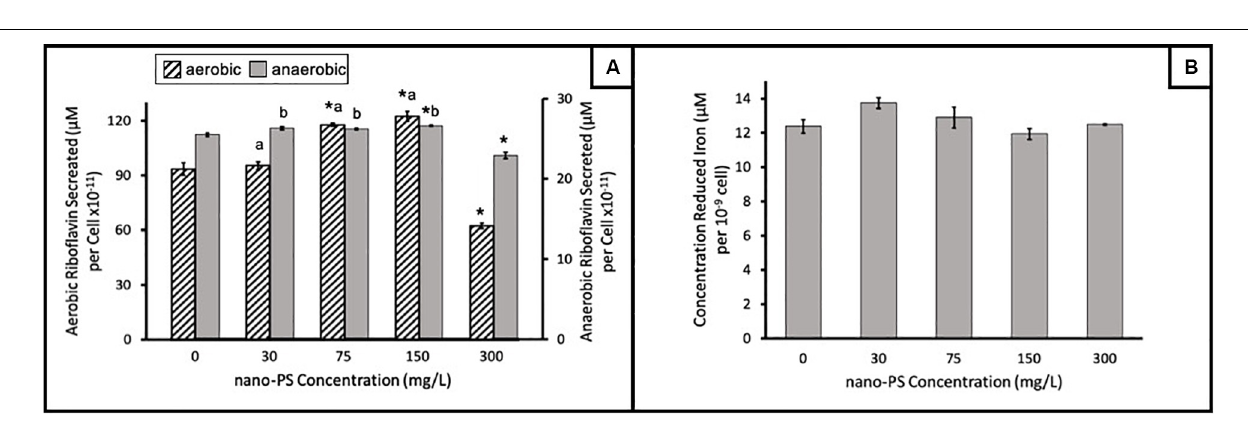
FIGURE 3 | (A) Riboflavin secreted per cell from S. oneidensis as a function of exposure concentration of nano-PS in aerobic (diagonal lines) and anaerobic (solid gray) conditions. A significant increase (* p < 0.05) was observed as compared to the control (0 mg/L nano-PS) for aerobic 75, and 150 mg/L nano-PS and anaerobic 150 mg/mL. However, 300 mg/mL was significantly decreased riboflavin secreted per cell as compared to the control. The highest exposure concentration, 300 mg/L nano-PS, was significantly different ( a or b p < 0.05) in secreted riboflavin compared to the other exposure concentration. The SEM among triplicate trials is represented by the error bars. (B) Iron reduced by S. oneidensis under anaerobic conditions exposed to varying concentrations of nano-PS does not show significant differences from the control (i.e., non-exposed) cells (single-factor ANOVA, p = 0.26). Error bars present the SEM of triplicate trials.